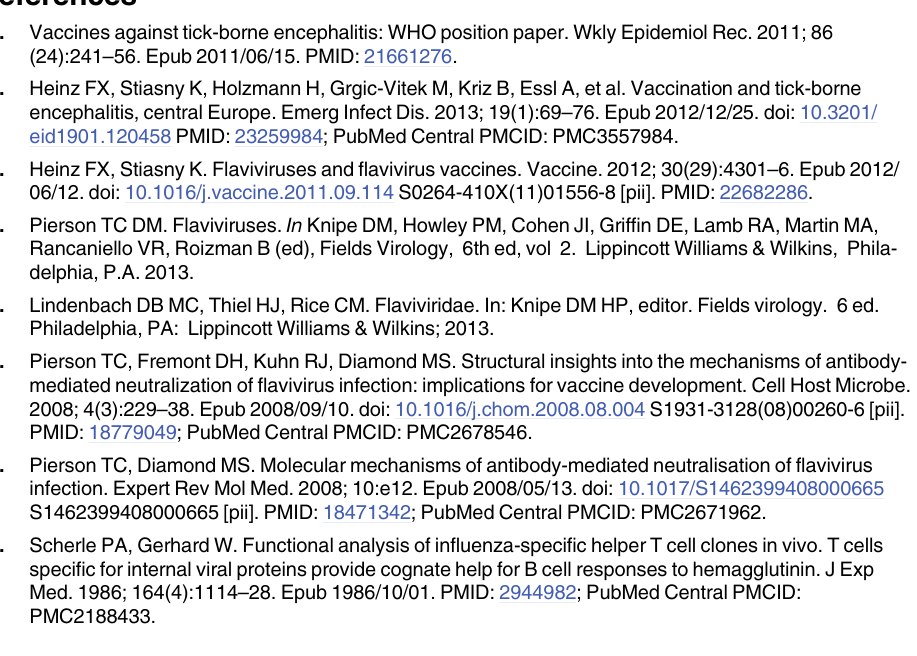
S2 Table. Fluorescent antibody conjugates. S3 Table. Univariate regression analysis to estimate the relationship between TBEV-spe- cific CD4 + T cell populations and TBEV-specific neutralizing antibody titers and TBE- V-IgG. S4 Table. Median fluorescence intensity (MFI) of IFN- γ in TBEV-specific CD4 + T cells from TBE patients and booster-vaccinated subjects. S5 Table. Median fluorescence intensity (MFI) of IL-2 in TBEV-specific CD4 + T cells from TBE booster-vaccinated subjects. S6 Table. TBEV E peptide minipools that induce Th1 subtype responses in TBE vaccinated